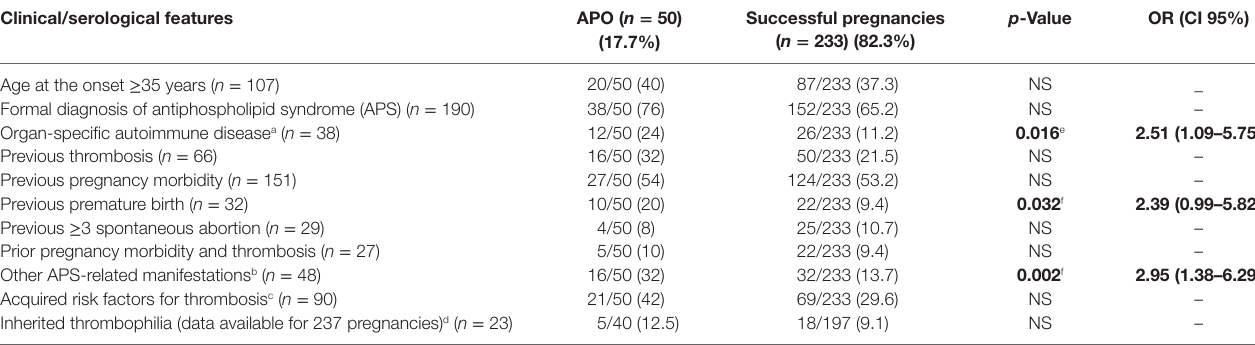
Table 4 | Univariate analysis of clinical features in successful and adverse pregnancy outcome (APO) pregnancies. clinical/serological features